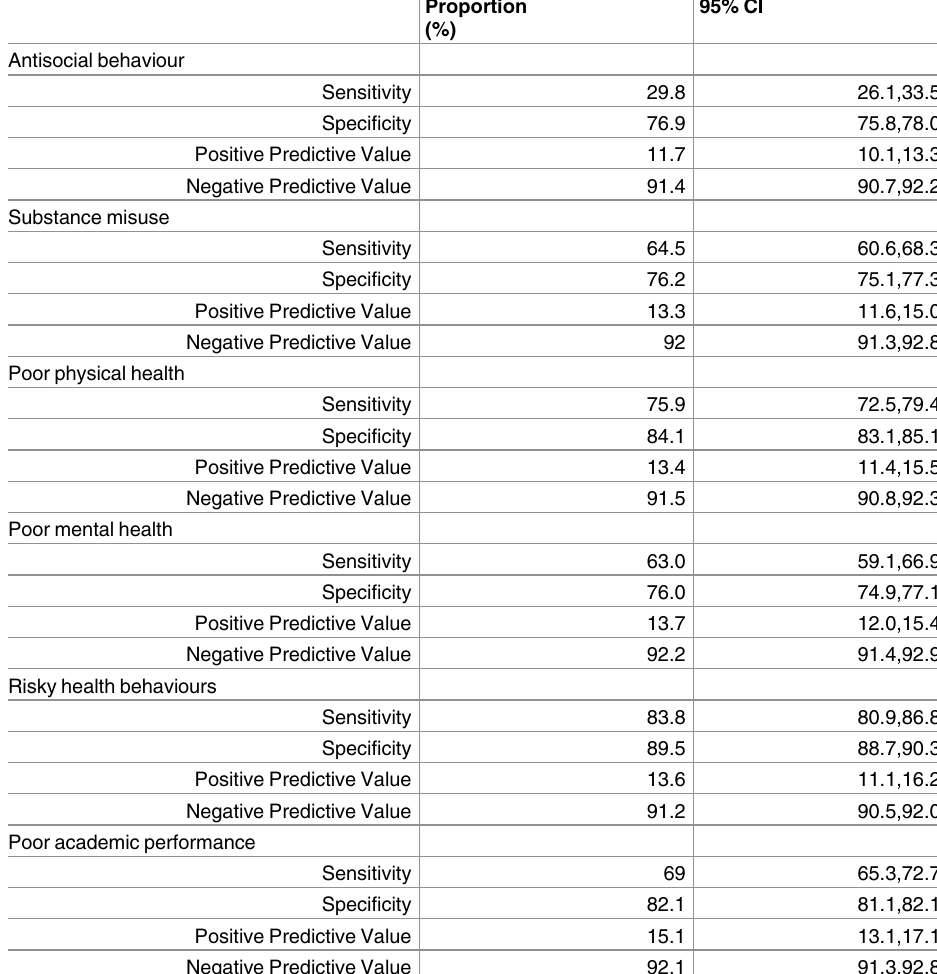
Table 3. Sensitivity, specificity, positive predictive value, negative predictive value for secondaryout- comes for high-risk classification, NLSCY, Canada,